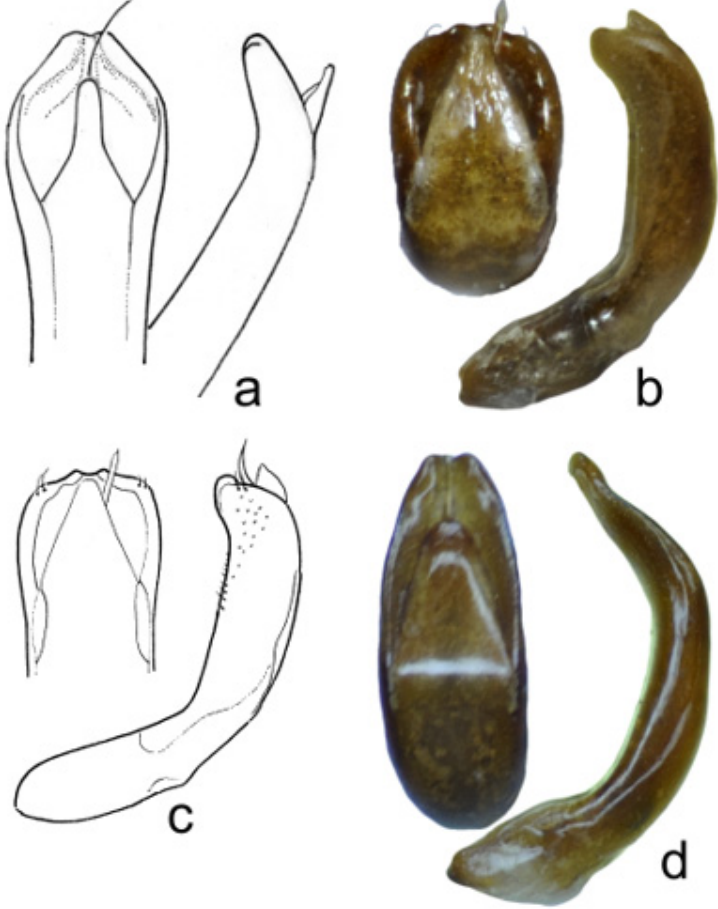
Figure 10. Chrysolina , male aedeagus, dorsal and lateral view: ( a ) Ch. liqingzhaoae , paratype; ( b , c ) Ch. marinae sp. nov., holotype; ( d ) Ch. genriki sp. nov.,